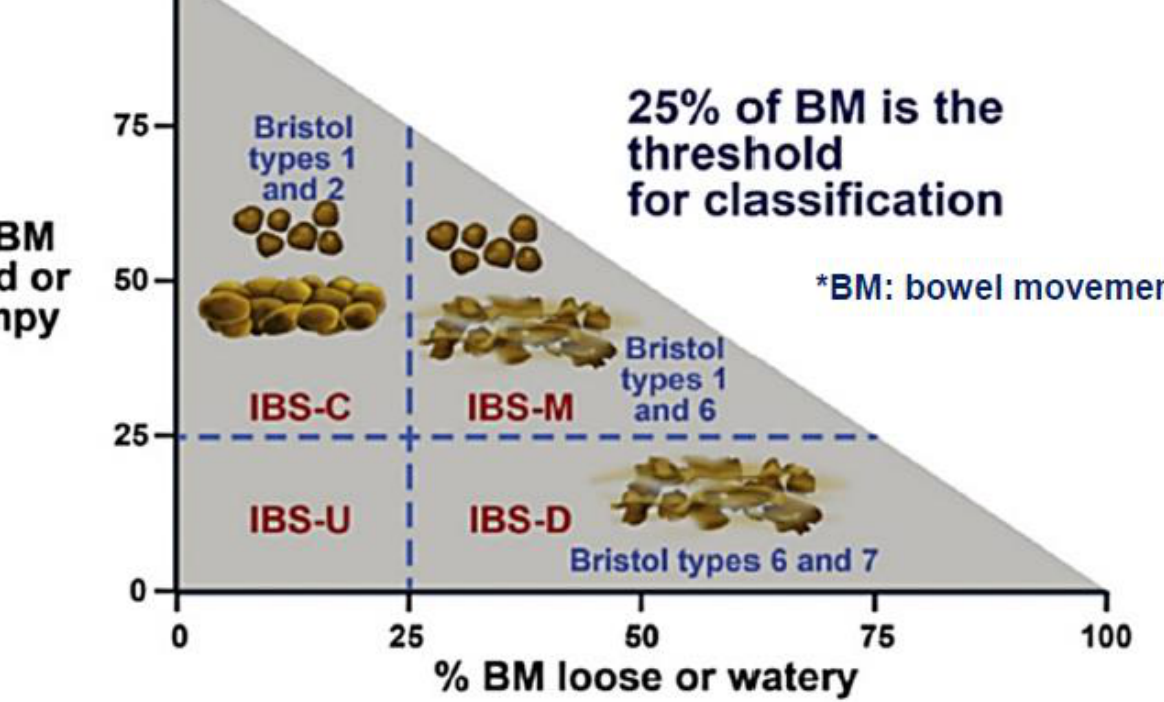
Figure 1. Rome IV criteria for IBS (May 2016).